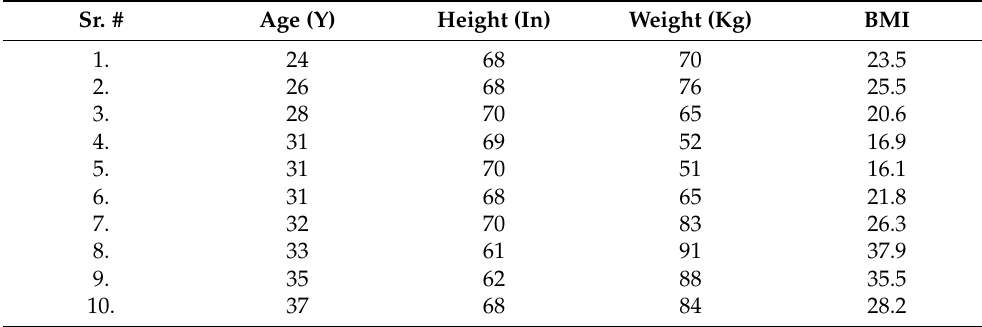
Figure 6. Experimental setup for single-person and multi-person breathing monitoring. Table 2. Participants